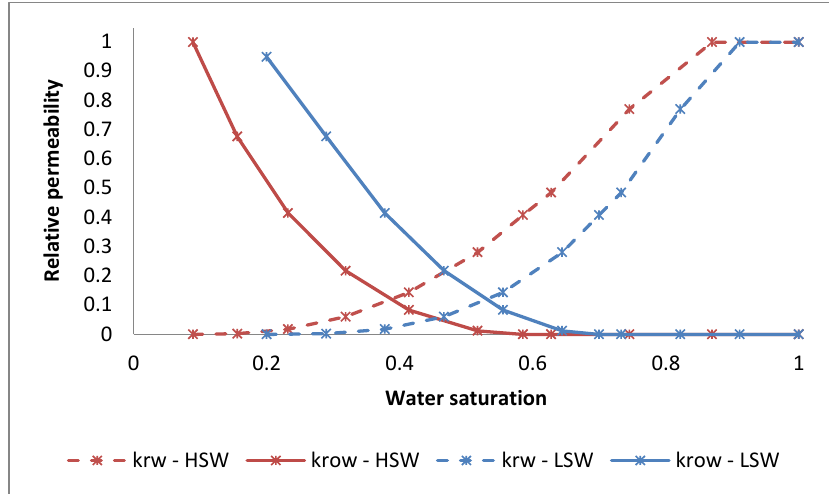
Figure 2. Water – oil relative permeability curves.